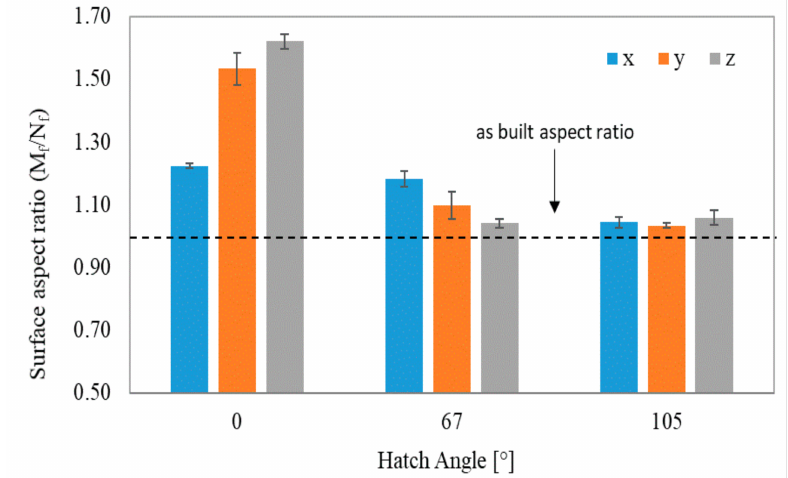
Figure 9. Surface aspect ratio comparison of compressed samples built using di ff erent hatch angles and build